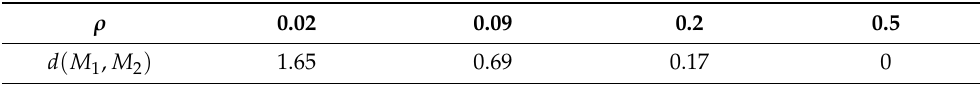
Table 3. Distance between the two representative activity